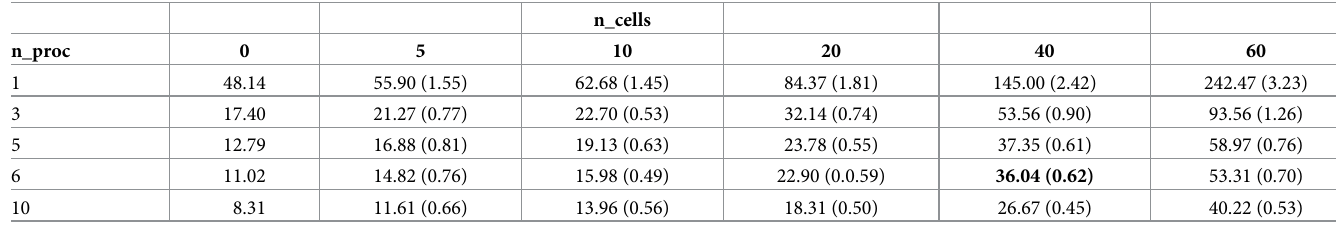
Table 1. CPU times in seconds for different number of cores and number of cells for 1000 simulation time steps which correspond to 0.1 ms of cell flow. The corre- sponding time per one blood cell is given in parentheses. The reference simulation is in bold.